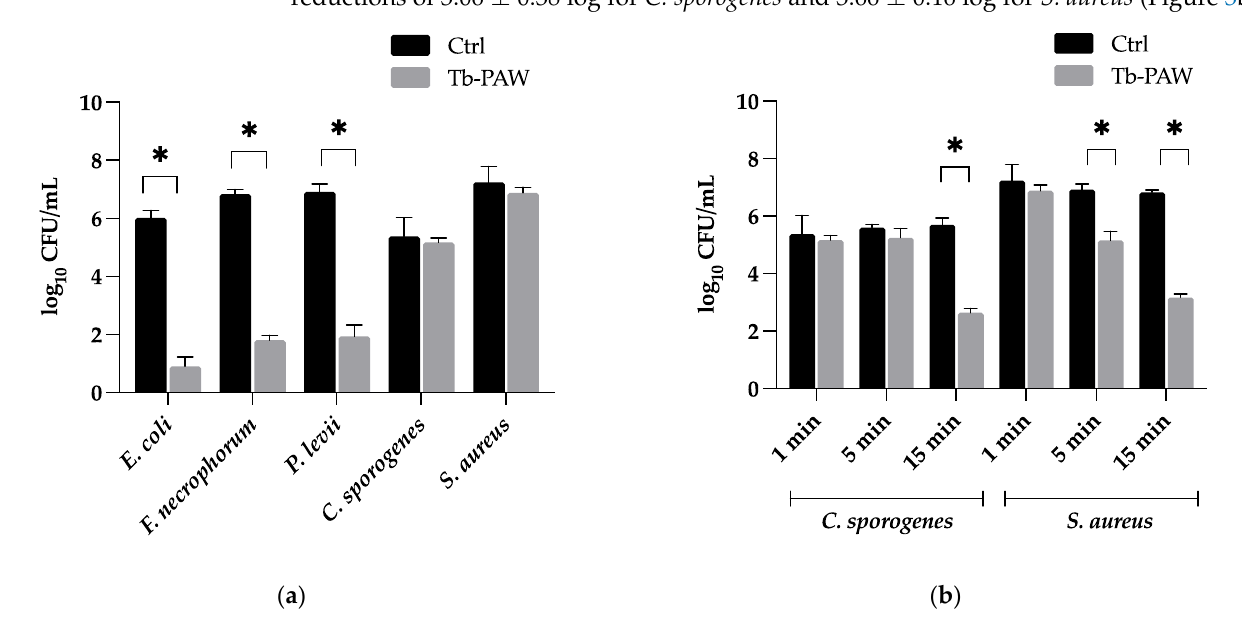
Figure 3. ( a ) Inactivation of Escherichia (E.) coli , Staphylococcus (S.) aureus , Fusobacterium (F.) necropho- rum , Porphyromonas (P.) levii and Clostridium (C.) sporogenes after 1 min of Tb-PAW treatment ( b ) Inactivation of C. sporogenes and S. aureus after 1 min, 5 min and 15 min of Tb-PAW treatment. Re- sults represent the mean ± standard deviation. Significant differences are defined as * p ≤ 0.05. Ctrl = Control (TRIS-buffer); Tb-PAW = TRIS-buffered plasma-activated water.